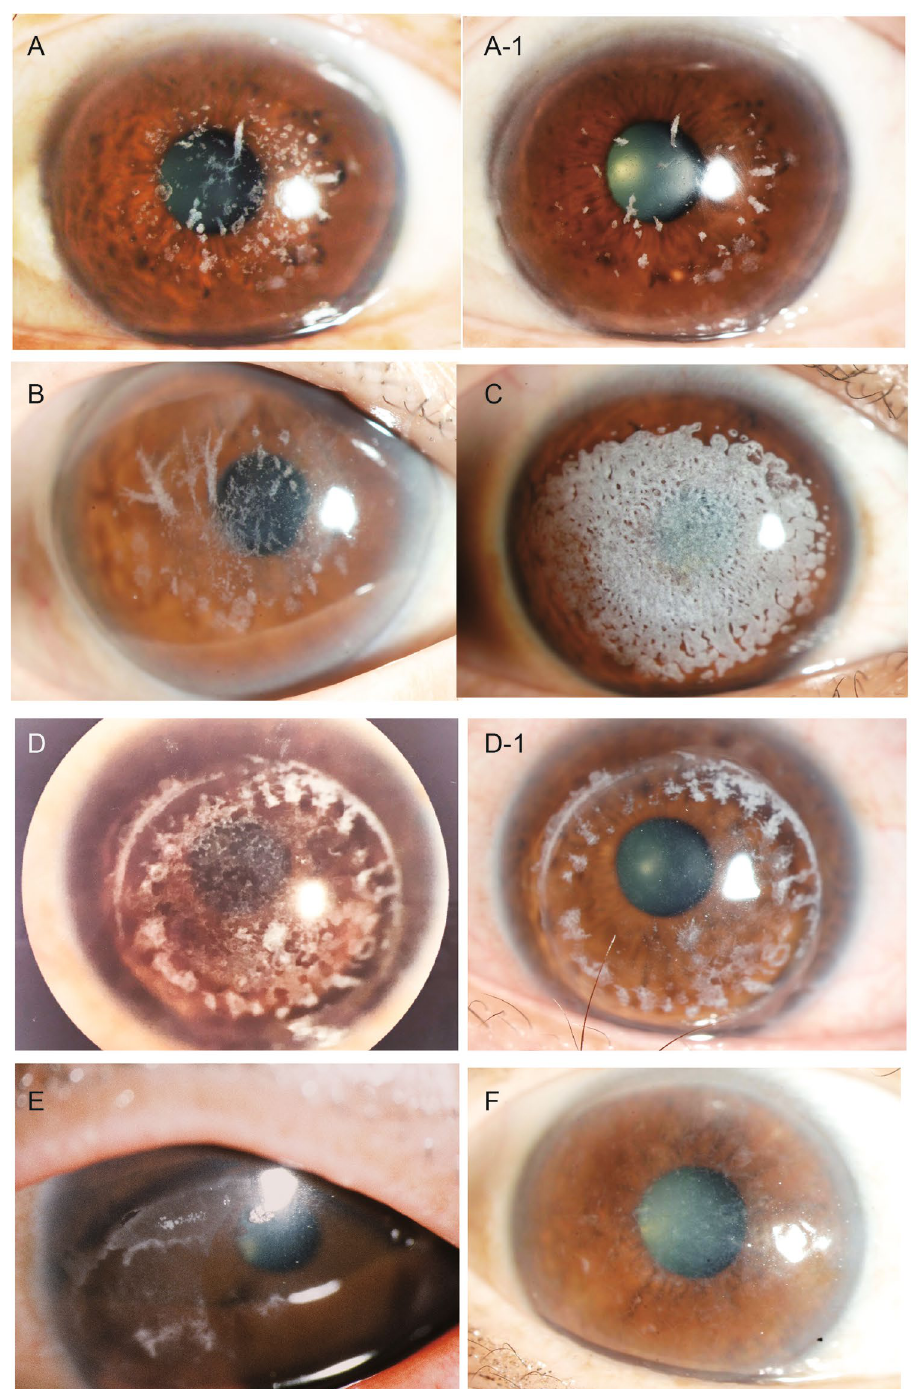
Figure 2. Slit-lamp microscopy photographs of the anterior segment at 18.5 years initial phototherapeutic keratectomy (PTK) for hetero-type granular corneal dystrophy (GCD) prior to re-excimer laser PTK (re-PTK) ( A ) and post 5 years ( A-1 ). The photographs at 20 years initial PTK for hetero-type GCD prior to re-PTK ( B ).These 2 eyes had the longest elapsed time period between the two PTK operations. The photographs of 46 months ( C ) and 31 months ( D ) after the initial PTK for homozygous-type GCD before re-PTK. The photographs at 6 months initial PTK homozygous-type GCD post re-PTK ( D-1 ). Images showing the pre-re- PTK findings of band keratopathy ( E ) and lattice corneal dystrophy ( F